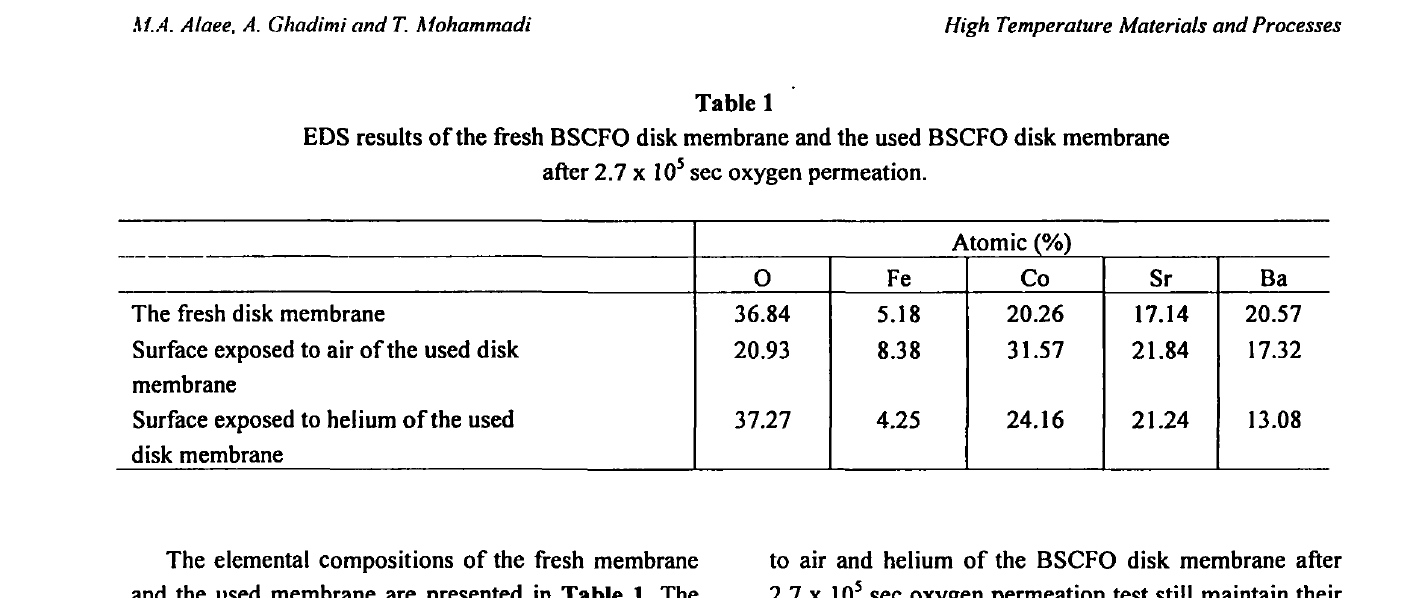
EDS results of the fresh BSCFO disk membrane and the used BSCFO disk membrane after 2.7 χ 10 s sec oxygen permeation.